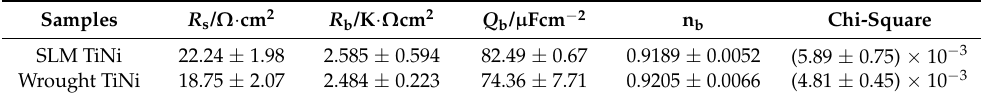
Table 1. EIS fitting parameters of SLM and wrought TiNi sample in